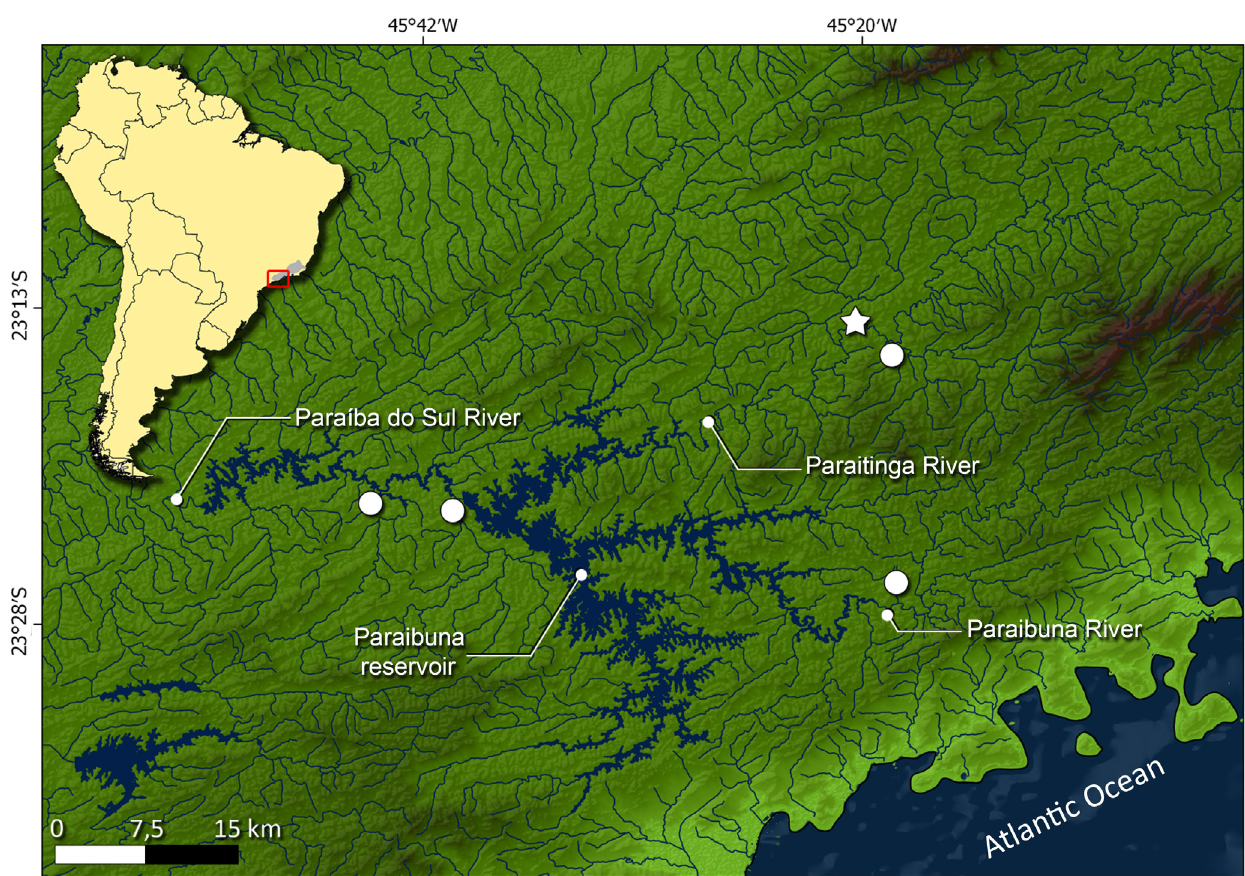
FIGURE 3 | Map of eastern portion of South America showing the type locality (star) and distribution of Cyphocharax tamuya . Symbols may represent more than one collection